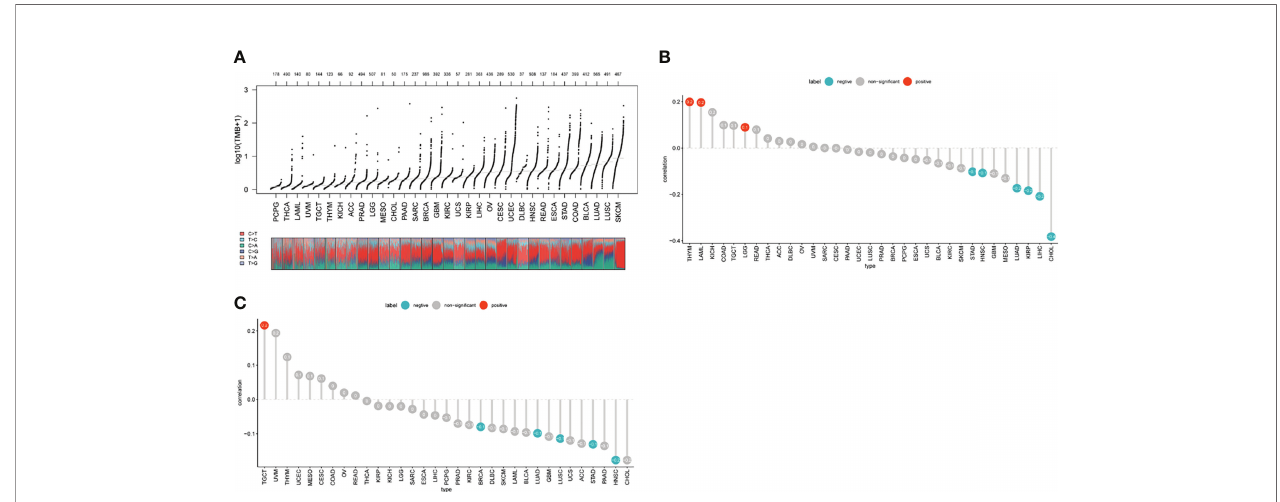
FIGURE 8 | (A) TMB distribution of each tumor, with UCEC having the highest TMB (B, C) TME, and MSI analysis. Red points represent a positive correlation, and blue dots represent a negative orrelation. Numbers represent Pearson ’ s coef fi